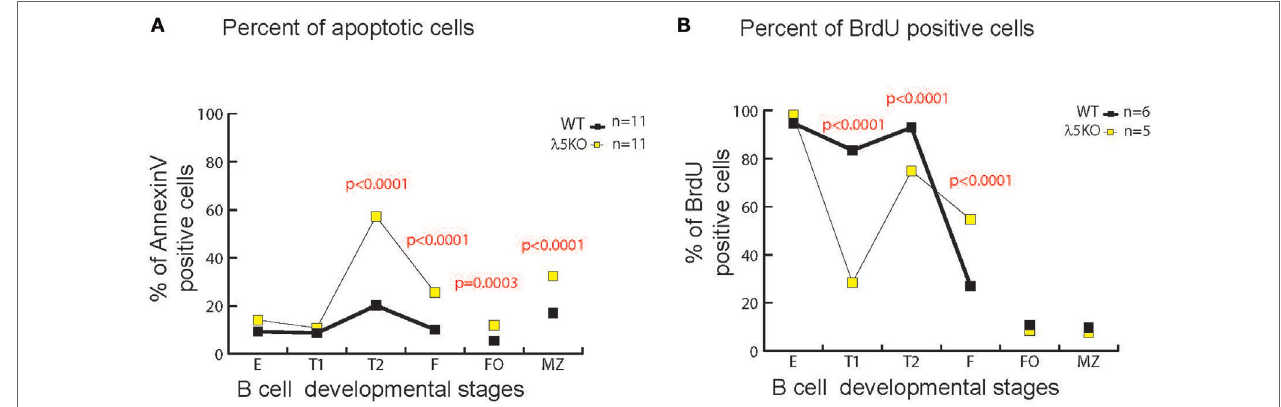
FigUre 6 | Apoptosis and cell turnover in λ 5KO versus wild-type (WT). (a) Comparison of the percentage of Annexin V positive (apoptotic) cells in λ 5KO versus WT mice. Data were obtained from 11 mice per group. (B) Comparison of bromodeoxyuridine (BrdU)-positive cells among selected B cell subsets as a measure of cell turnover in λ 5KO versus WT mice. Student’s t -test was used for statistical analysis. The p -values for differences that achieved statistical significance ( p ≤ 0.05) are